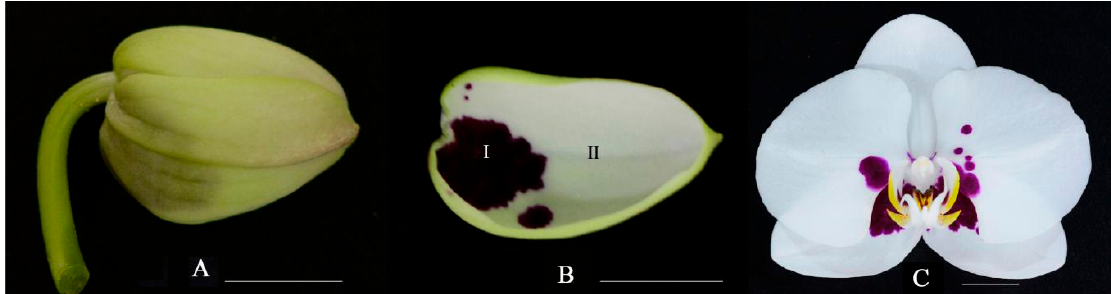
Figure 10. The flower tissue of Phalaenopsis ‘Panda’. Bars = 1 cm. ( A ) Full bud; ( B ) Sepal; I. spot area; II. non-spot area. ( C ) Full bloom stage.